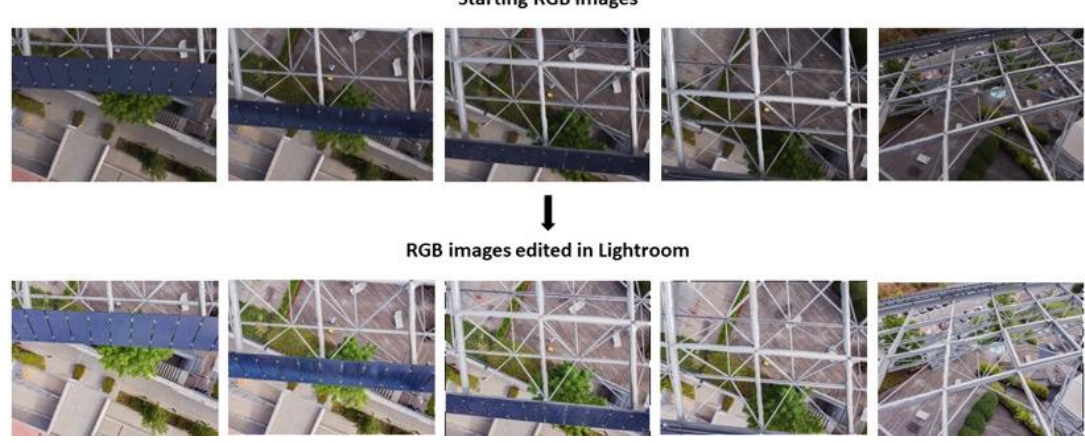
Figure 25. Changing the brightness and contrast of images from the UAV platform.